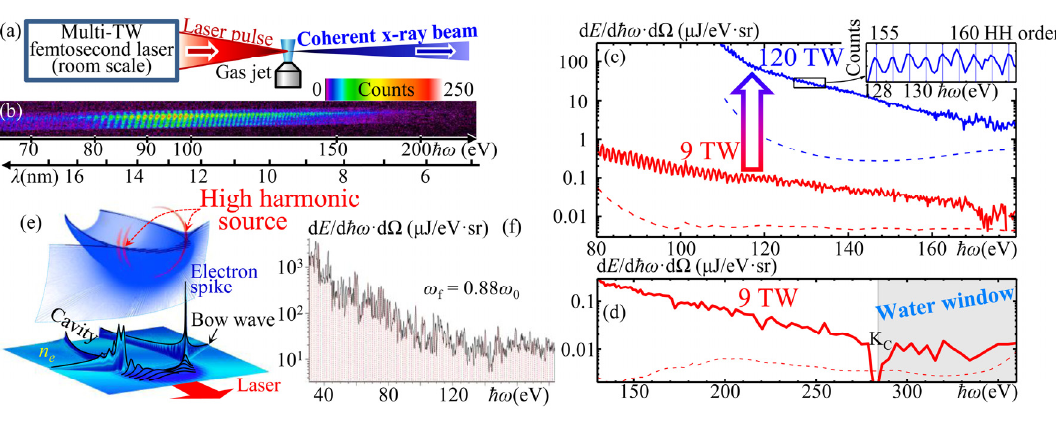
Figure 18. High-order harmonics generation by multi-TW femtosecond lasers in gas jets [89,25]. ( a ) Experimental setup; ( b ) Typical single-shot raw data; ( c ) Harmonics spectra in absolute units and scalability with the laser power; ( d ) “Water window” radiation; ( e ) 3D PIC simulations demonstrating electron density spike and location of high harmonics source; ( d ) Harmonics spectrum from high-resolution 2D PIC